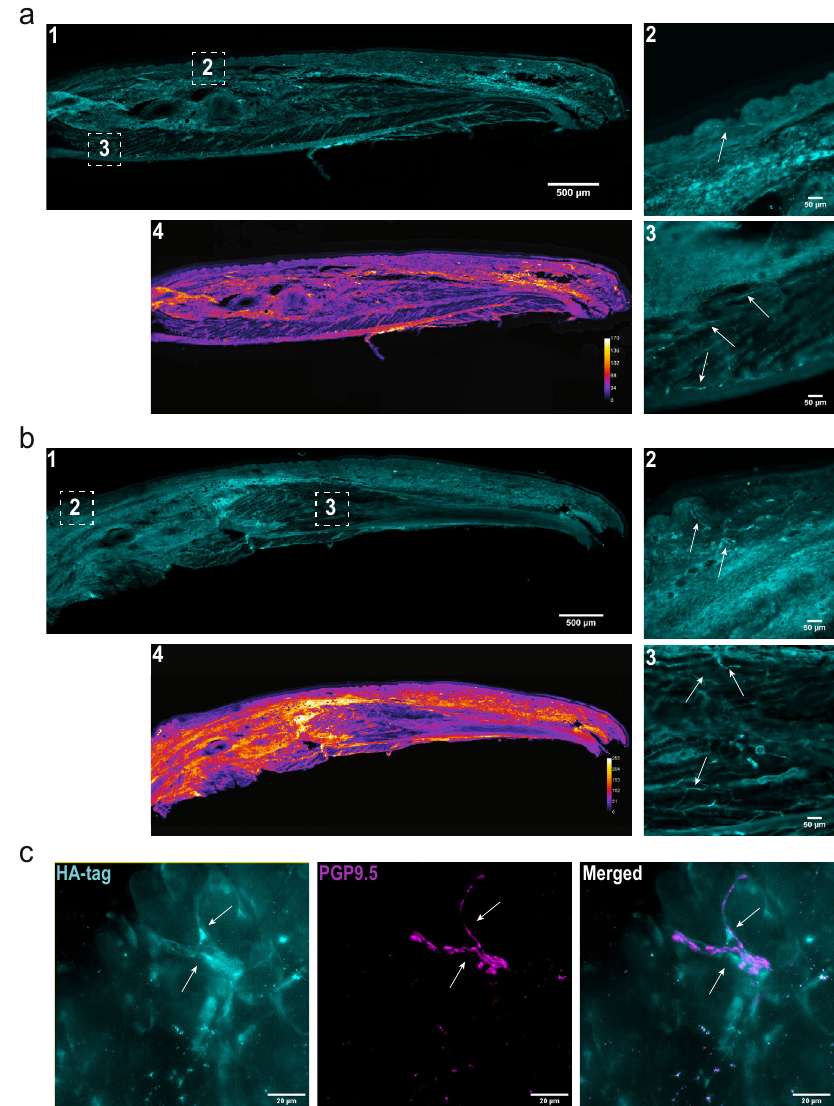
Fig. 3 Lipidated peptides in fi ltrate peripheral neuronal afferents. a Tilescan immuno fl uorescent image of a mouse hind paw following injection of an antigenic lipidated-HA peptide into the hind paw of a naïve C57BL/6 mouse under control conditions. The HA-peptide allowed for immuno fl uorescent visualization of lipidated peptide distribution following injection. This experiment was repeated, independently, twice with similar results. a4 Heatmap analysis of immunoreactivity. a1 The lipidated-HA peptide preferentially partitioned to the dermis, within lipid dense areas. a2 Insert depicting HA immunoreactivity in peripheral afferents within the dermis. a3 Insert depicting immunoreactivity in peripheral afferents in muscle tissue. While afferents exhibited immunolabeling, muscle cells did not. b Injection of an antigenic lipidated peptidomimetic into the hind paw of a naïve C57BL/6 mouse under CFA-induced in fl ammation. This experiment was repeated, independently, twice with similar results. b4 Heatmap analysis depicted greater retention of peptide within in fl amed tissues. b1 Again, lipidated-HA peptide preferentially partitioned to the dermis, speci fi cally, lipid dense areas. b2 Insert depicting immunoreactivity in peripheral afferents in the dermis. b3 Insert depicting immunoreactivity in peripheral afferents and in muscle tissue. c Immuno fl uorescent image depicting localization of the membrane bound HA-peptide and the cytoplasmic pan-neuronal marker PGP9.5. This experiment was repeated, independently, twice with similar results. [Left] HA-peptide alone. Arrows highlight the contour of the fi ber. [Middle] PGP9.5 alone. Arrows illustrate the contour of the neuron afferent observed with the HA-peptide. [Right] Merged image. Arrows show that the HA-peptide and PGP9.5 immunoreactivity follow similar